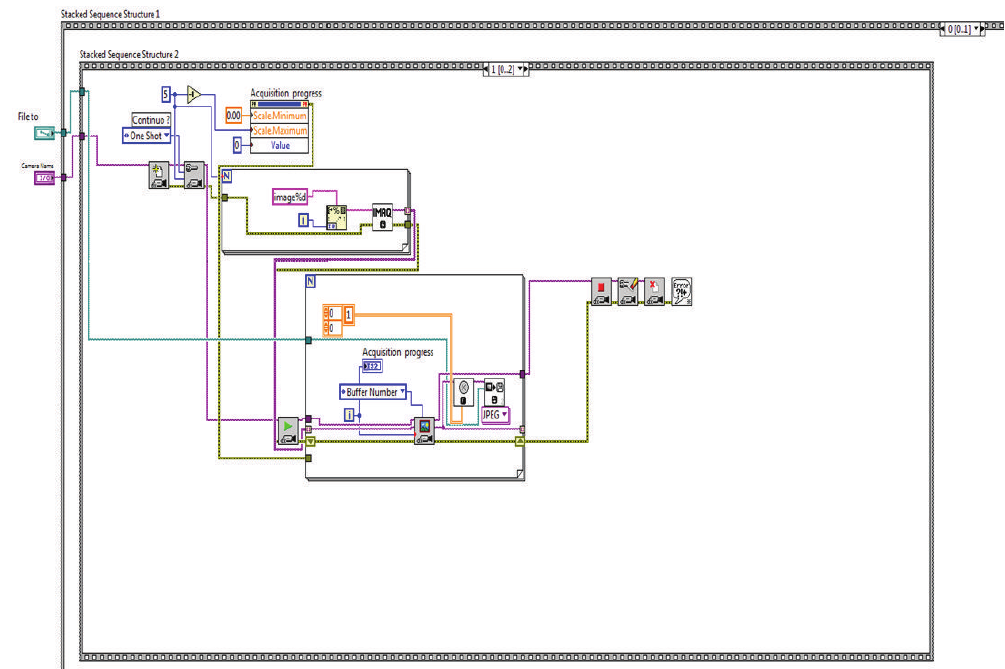
Figure 4: Sub-VI for image